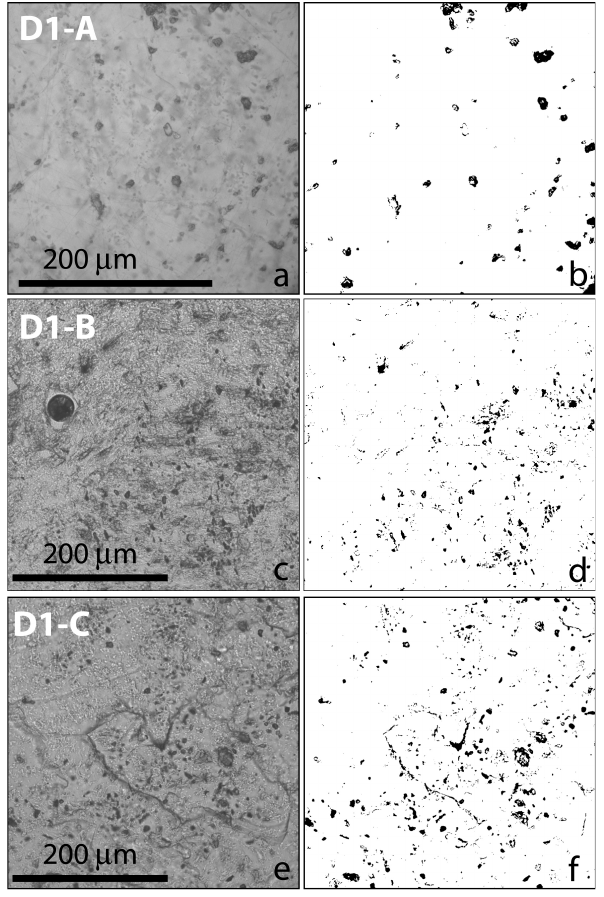
Fig. 5. Examples of microphotographs of stalagmite thin sections D1-A (a) and D1-B (c) , both characterized by lower water yields, and thin section D1-C (e) from an area characterized by higher wa- ter yields. Also shown are the respective processed black and white images (b, d, f) . The large dark circle in photograph D1-B (c) is an artefact from thin section production and was not taken into account for black pixel counting. Images (b) (D1-A) and (d) (D1-B) show lower percentages of black pixels (2.3% and 2.7%, respectively) than image (f) (D1-C, 4.8%). Note that these numbers do refer to the actual shown microphotographs and thus can deviate from the mean volume fractions of fluid inclusions given in Sect. 3.2, which average over 8 to 16 individual